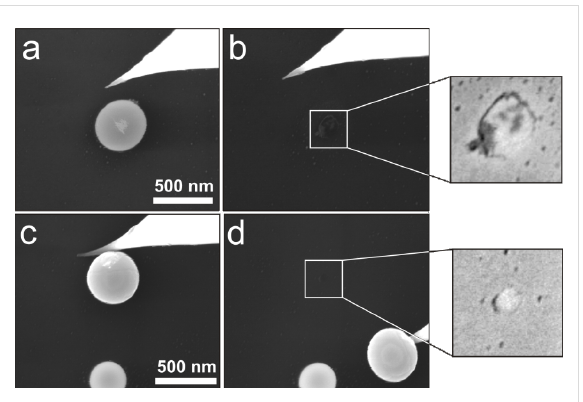
the experimental friction force values mostly correspond to icosahedral and truncated icosahedral NP shapes.